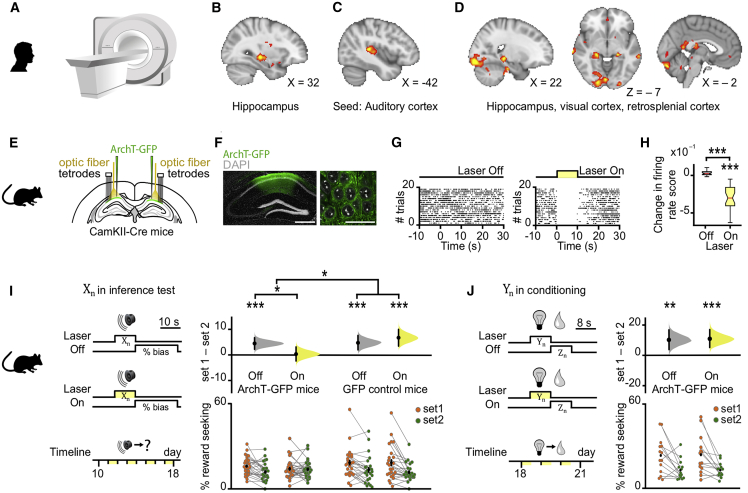
Macroscopic Inference Network in Humans and the Necessary Contribution of dCA1 to Inference in Mice(A) 7T fMRI used to measure the BOLD signal during the inference task (Figure 1C).(B) Significant right hippocampal BOLD signal during correct inference (“correct” – “incorrect” inference: right, t21 = 4.15, p = 0.022; left, t21 = 2.80, p = 0.221; Figure S3A; Table S1).(C) Significant BOLD signal in auditory cortex during inference test trials (“inference trials” – “conditioning trials”: t21 = 14.76, p < 0.001).(D) Psychological-physiological interaction showing differential co-activation with auditory cortex (seed region, C, Figure S3B) on correct versus incorrect inference trials (hippocampus: t21 = 4.23, p = 0.015; and other regions: retrosplenial cortex: t21 = 3.88, p = 0.012; visual cortex: t21 = 4.77, p < 0.001; Table S2).(E–J) In mice. Yellow, laser on; gray, laser off. (E) Schematic: ArchT-GFP viral injections, optic fibers, and tetrodes targeting dCA1 of CamKII-Cre mice for ensemble recording and manipulation. (F) dCA1 (green) ArchT-GFP expression. Scale bar, 500 μm (left), 50 μm (right). (G) Raster plot showing photo-silencing of spiking activity for an example dCA1 pyramidal cell from an ArchT-GFP mouse. (H) Light-induced changes in firing rate for simultaneously recorded dCA1 pyramidal cells in an example ArchT-GFP mouse (laser on: t30 = −10.86, p < 0.001; laser off – laser on: t30 = 10.88, p < 0.001). Rate changes expressed for each cell as the differences between laser on and laser off firing over the sum (scores; center line, median; box limits, upper and lower quartiles; whiskers, 1.0× interquartile range). (I and J) Left panel: schematic of light delivery. Bottom right panel: raw data points for set 1 (orange) and set 2 (green); black dot, mean; black ticks, ± SEM. Top right panel: behavioral measures of reward seeking bias shown using DABEST plots, as in Figures 1E and 1F. (I) dCA1 light delivery during auditory cues Xn in the inference test impaired reward-seeking bias in ArchT-GFP mice (set 1 – set 2: laser off p < 0.001; laser on p = 0.794; laser off – laser on: t54 = 2.25, p = 0.029; alpha set to 0.05; Figure S2I) but not in GFP control mice (set 1 – set 2: laser off p < 0.001; laser on p < 0.001; laser off – laser on: t46 = −0.85, p = 0.399; alpha set to 0.05). The significant reward-seeking biases (ArchT-GFP laser off; GFP control laser off and on) remained significant with Bonferroni correction for four comparisons, alpha set to 0.013. A significant interaction was also observed between the ArchT-GFP and GFP control mice (group × laser interaction, two-way ANOVA, F1,100 = 4.42, p = 0.038). (J) dCA1 optogenetic silencing during visual cues Yn, presented after the inference task was complete, did not impair reward-seeking bias in ArchT-GFP mice (set 1 – set 2: laser off p = 0.003; laser on p < 0.001; laser off – laser on: t26 = −0.14, p = 0.891).See also Table S4.